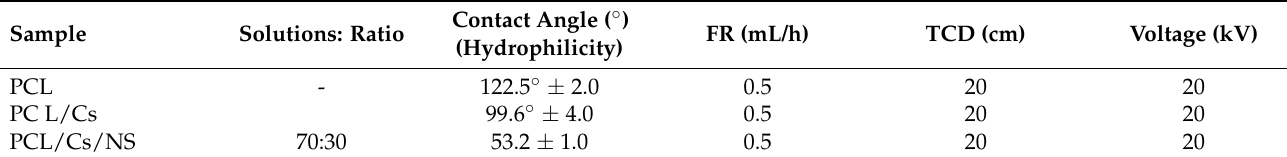
Table 2. Hydrophobicity and electrospinning conditions of the electrospun nanofibers.